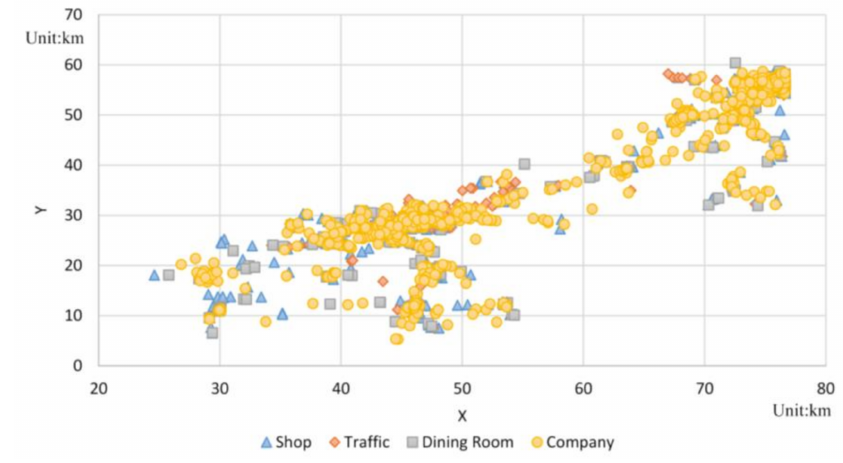
Figure 4. The position of each feature in Jinan is displayed.